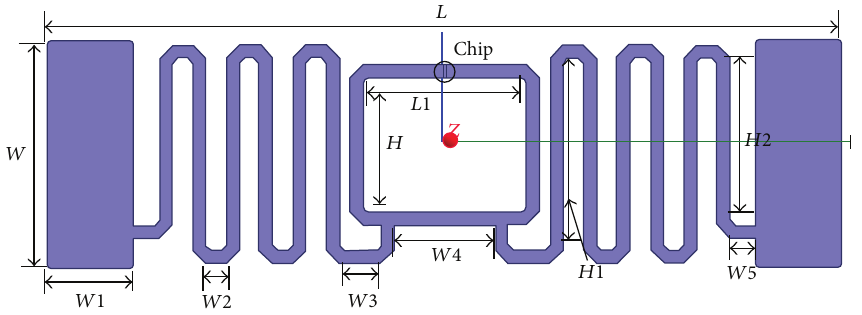
Figure 1: Structural configuration of the proposed antenna.